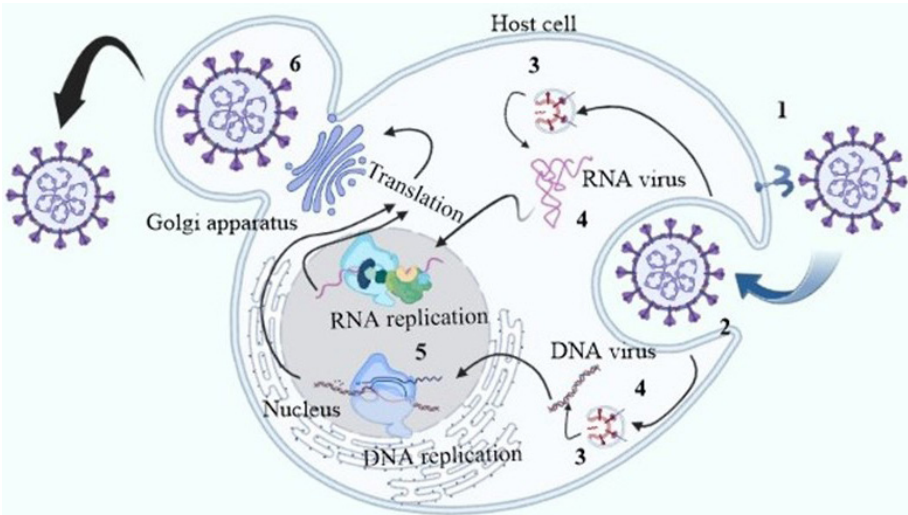
Figure 1. The antiviral peptides blocking sites of certain viral replication cycle. The inhibition sites are 1: viral association; 2: viral penetration; 3: endosomal escape; 4: viral uncoating; 5: viral genome replication; 6: release of mature